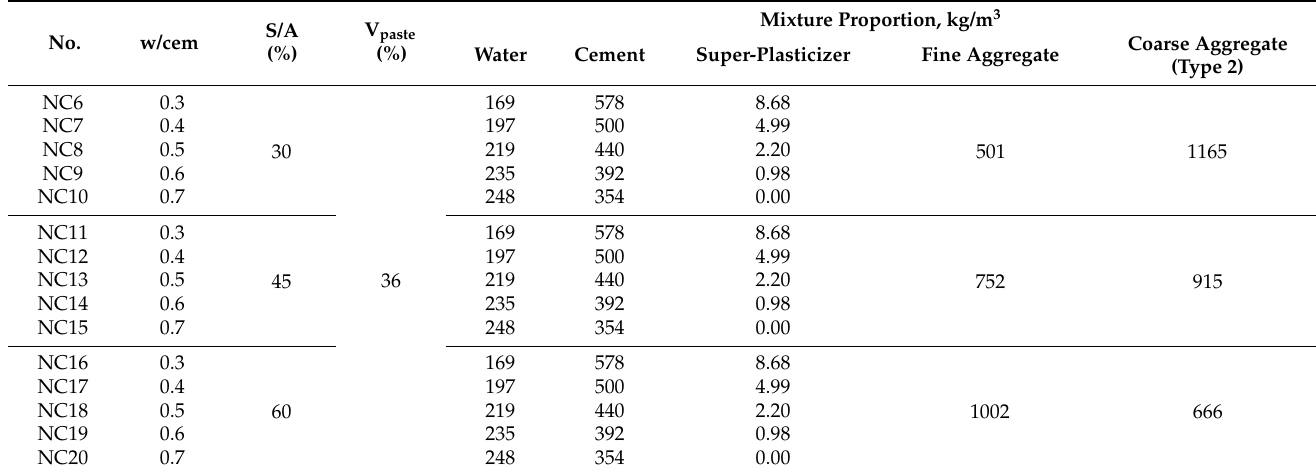
Table 2. Mixture proportions of various levels of coarse aggregate content in normal concrete.